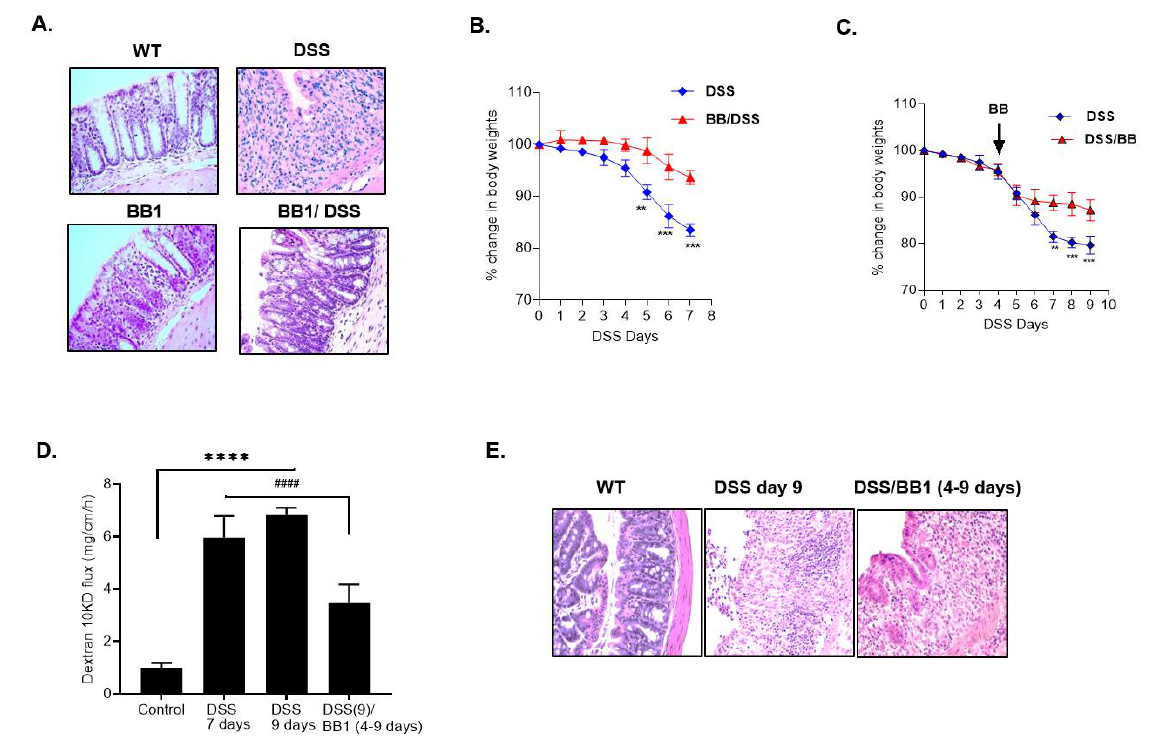
Figure 6. Protective and therapeutic effects of BB1 on DSS-induced colitis. ( A ) H & E staining of colonic mucosa after DSS administration showed ulceration of colonic mucosal surface with loss of surface epithelium and crypts and diffuse infiltration of inflammatory cells. BB1 administration attenuated the DSS-induced ulceration and loss of colonic mucosal architecture and the inflammation was reduced (BB1 treatment started 2 days prior to the 7-day DSS treatment). H & E, 200×. ( B ) BB1 prevented the DSS-induced body weight loss. ** p < 0.01 vs. DSS; *** p < 0.001 vs. DSS. ( C ) BB1 treatment attenuated the DSS-induced body weight loss over the 9-day experimental period. (BB1 treatment started 4 days after DSS administration and continued up to the 9-day experimental period). ** p < 0.01 vs. DSS; *** p < 0.001 vs. DSS. ( D ) DSS caused a marked increase in mouse colonic permeability to dextran-10 kDa over 9 days of DSS administration, and BB1 promoted the healing from the DSS-induced increase in mouse colonic permeability over the 9-day experimental period. (BB1 administration started 4 days after DSS treatment and continued up to the 9-day experimental period) **** p < 0.0001 vs. control; #### p < 0.0001 vs. DSS. ( E ) H & E staining of colonic mucosa after DSS administration (9-day experimental period) showed ulceration of colonic mucosal surface with loss of surface epithelium and crypts and diffuse infiltration of inflammatory cells. BB1 treatment 4 days after DSS administration attenuated the DSS-induced inflammation (BB1 treatment started 4 days after DSS treatment and continued up to 9 days). H & E, 200×.